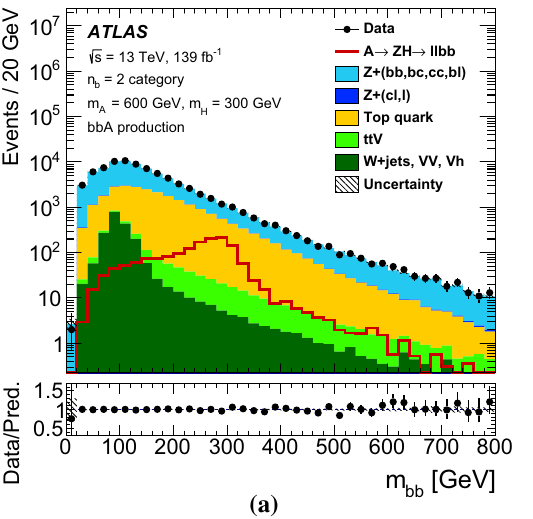
production cross section times the branching ratios B ( A → Z H ) and B ( H → bb ) corresponds to 1 pb. The same conventions as in Fig. 2 are